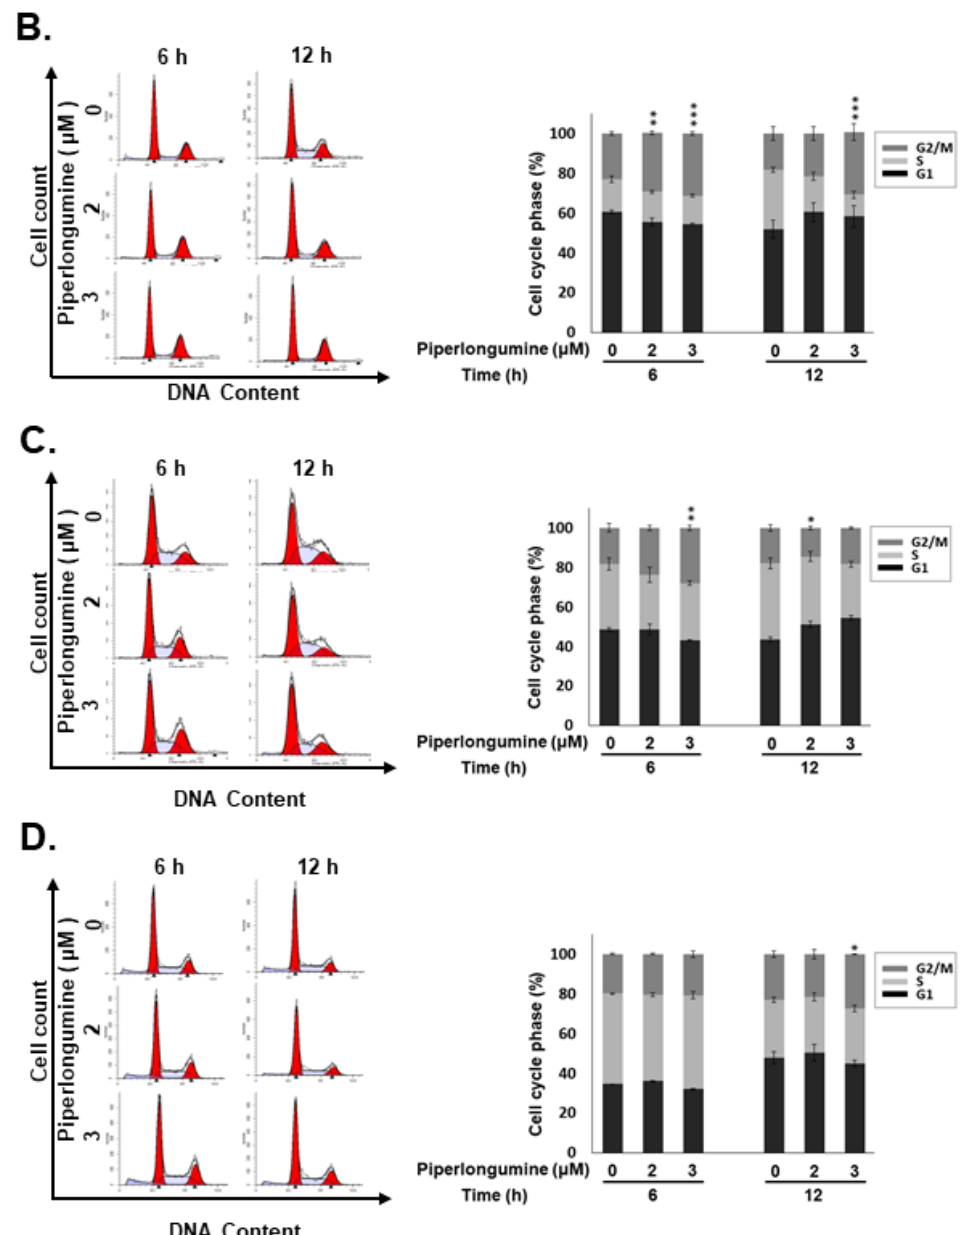
Figure 2. Induction of cell cycle arrest at the G2/M phase by piperlongumine (PL) in human thyroid cancer cells. Human thyroid cancer cells, namely, ( A ) IHH-4, ( B ) WRO, ( C ) 8505c, and ( D ) KMH-2 cells, were incubated with a control medium or PL, and the cell cycle was examined with fluorescence- activated cell sorting (FACS) flow cytometry. Dimethyl sulfoxide (DMSO) was used as a negative control. Three independent experiments were conducted. * indicated comparing with the untreated group. * indicates p < 0.05. ** indicates p < 0.01. *** indicates p <